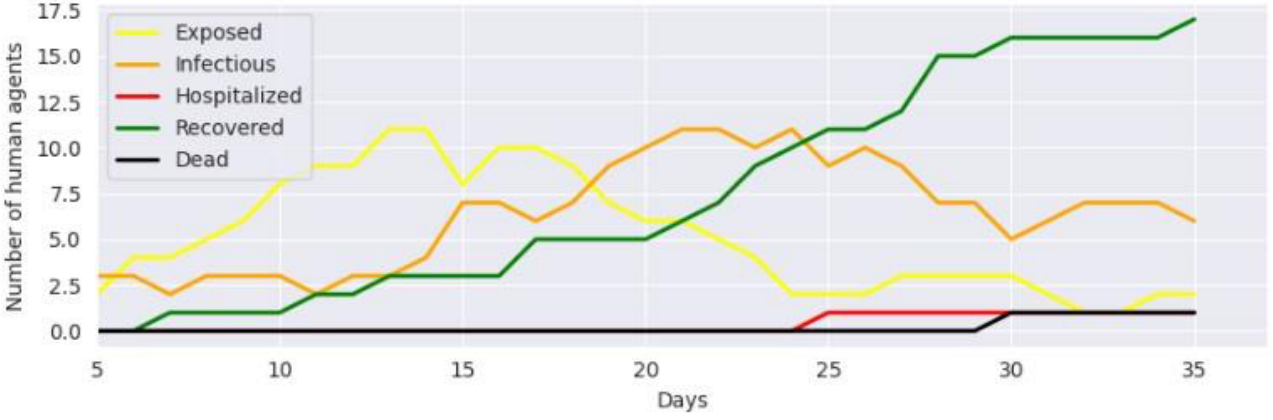
Figure 6. The momentum number of human agents in each status over the simulation (the result of an example run); each agent is a representative of 100 people.